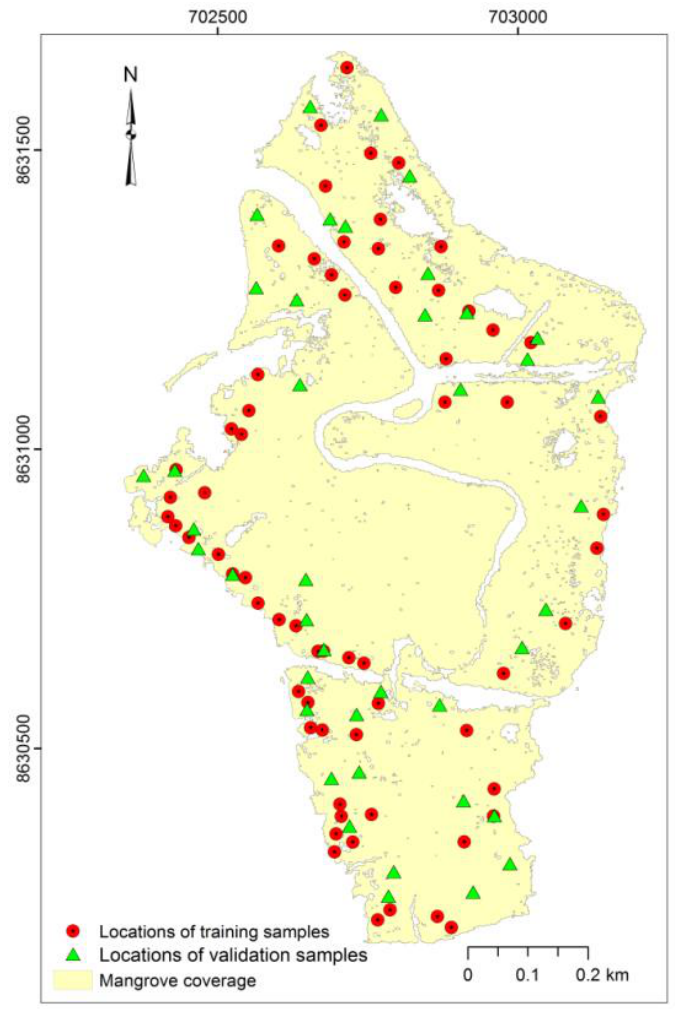
Figure 5. The locations of field samples available for calibration and validation purposes, and mangrove coverage extracted from the WV2